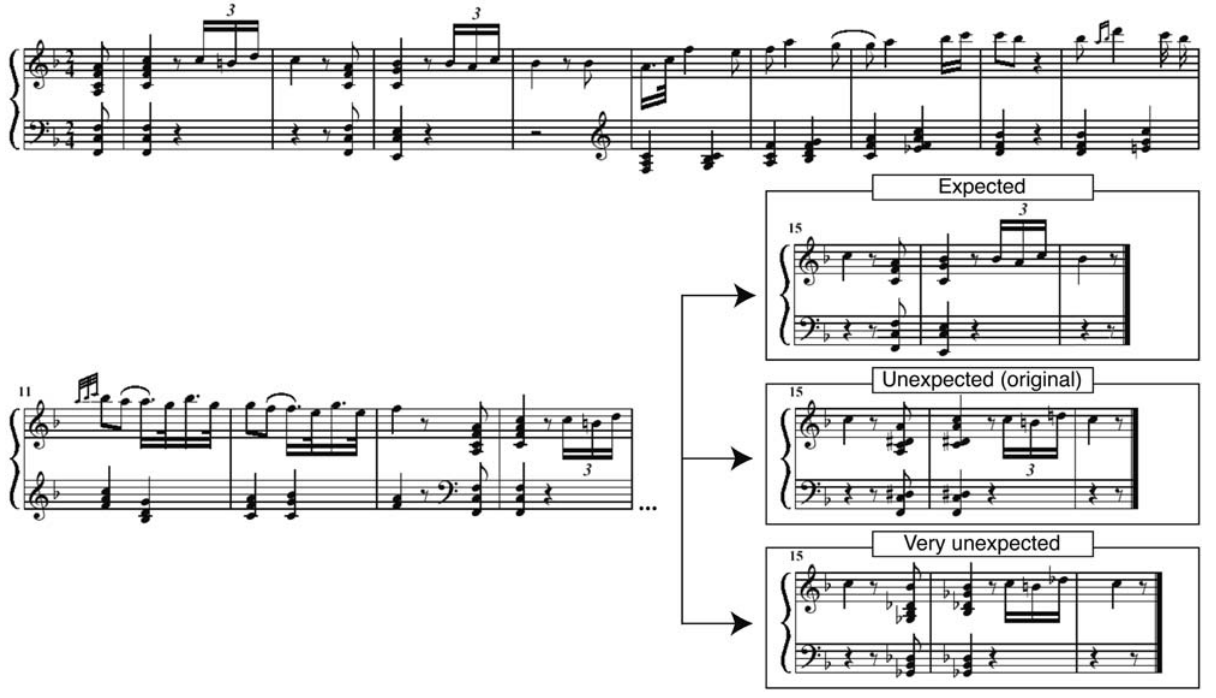
Figure 1. Examples of experimental stimuli. First, the original version of a piano sonata was played by a pianist. This original version contained an unexpected chord as arranged by the composer (see middle panel in the lower right). After the recording, the MIDI file with the unexpected (original) chord was modified offline using MIDI software so that the unexpected chord became expected, or very unexpected chord (see top and bottom panels). From each of these three versions, another version without musical expression was created by eliminating variations in tempo and key-stroke velocities (excerpts were modified offline using MIDI software). Thus, there were six versions of each piano sonata: Versions with expected, unexpected, and very unexpected chords, and each of these versions played with and without musical expression.